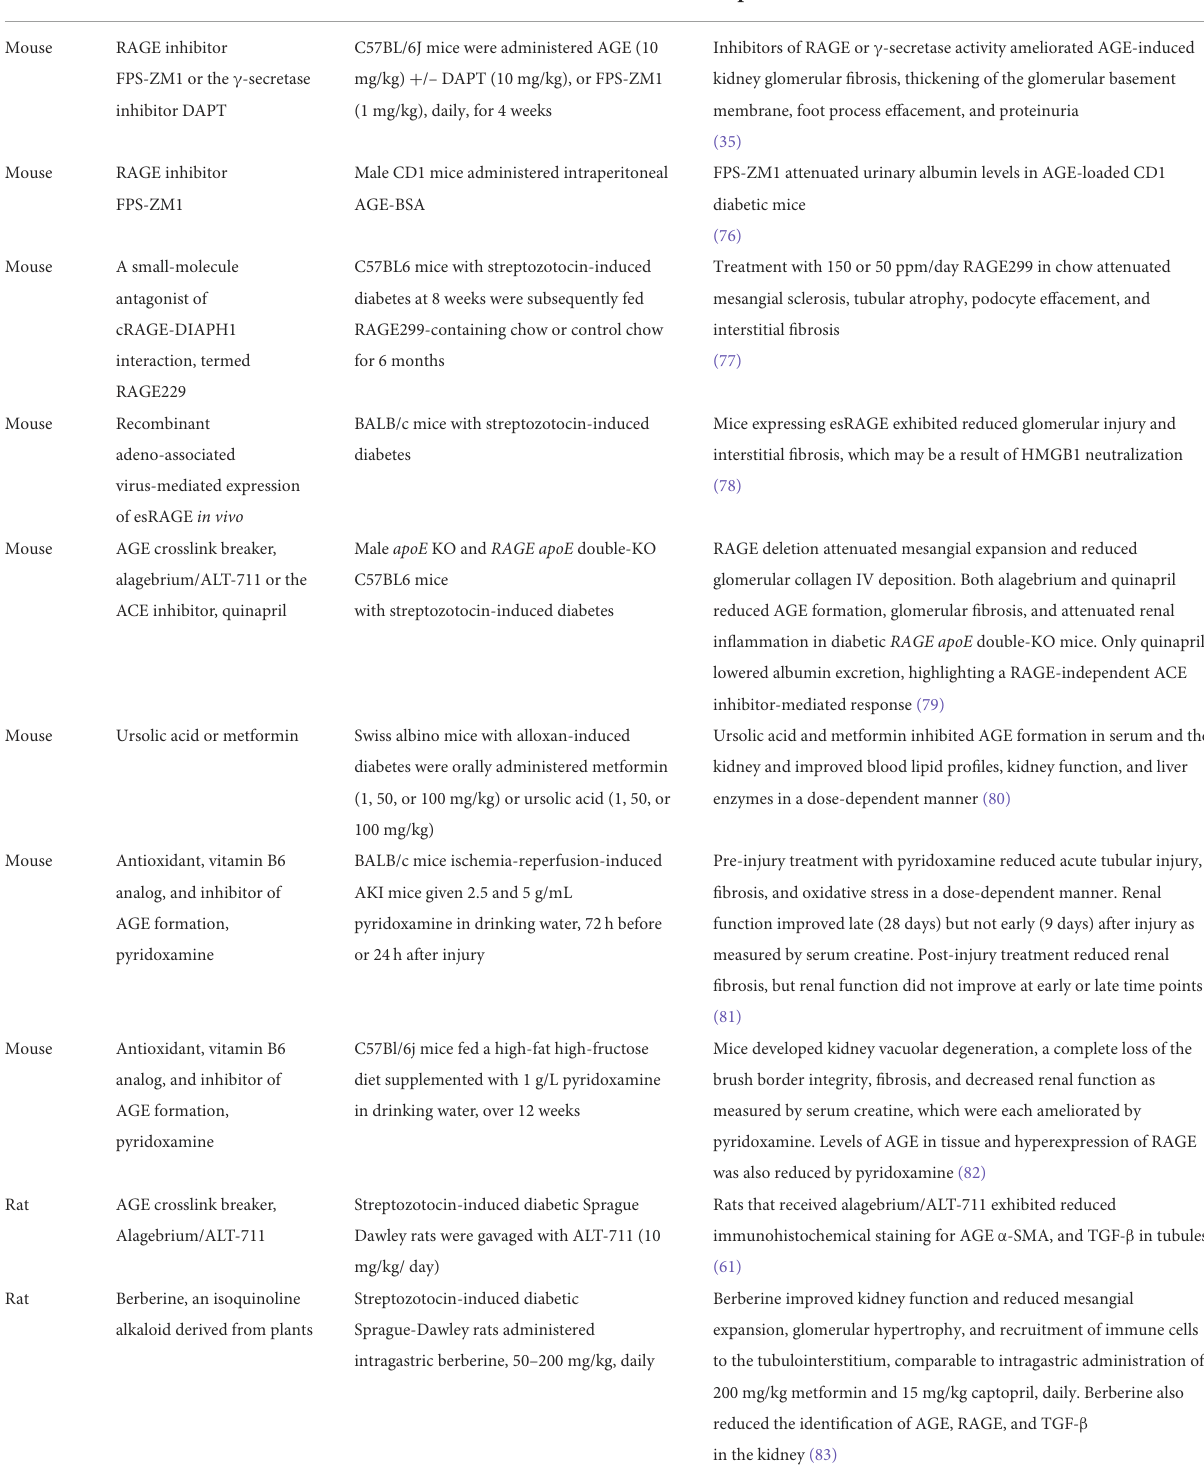
TABLE 1 Possible approaches to inhibiting RAGE in treating